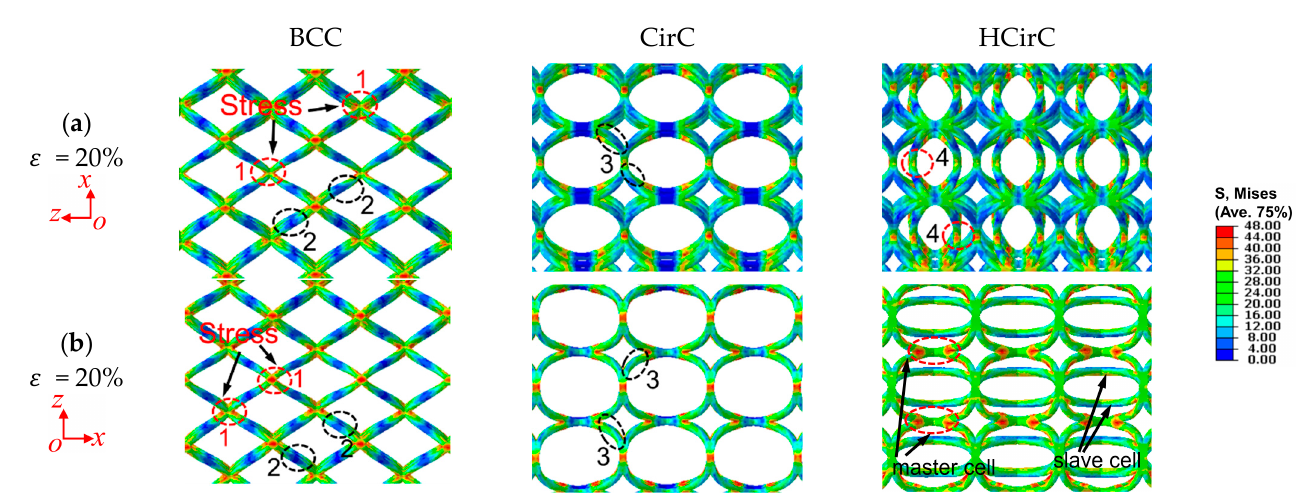
Figure 14. Local views of the stress distribution of lattice structures BCC, CirC, and HCirC: ( a ) compression along the x -axis; ( b ) compression along the z -axis.